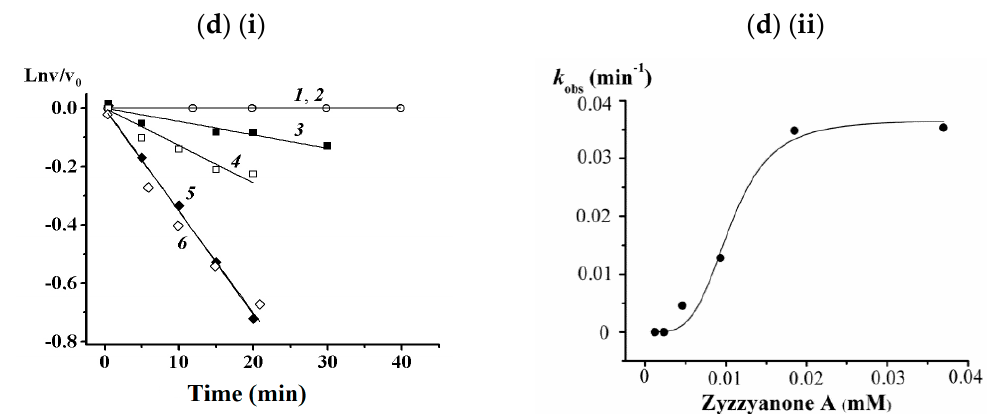
Figure 2. The results of kinetic studies of the α -PsGal inactivation by tested alkaloids: ( i ) the kinetic change of the residual activity of the enzyme ( v/v 0 ) in semilogarithmic coordinates at the presence of different concentrations of alkaloids; ( ii ) the inactivation rate ( k obs ) dependence on the concentration of alkaloids; ( a ) isoaaptamine: 814 µ M ( 1 ), 1.63 µ M ( 2 ), 3.255 µ M ( 3 ), 6.51 µ M ( 4 ), 10.417 µ M ( 5 ); ( b ) 9-demethylaptamine: 0.104 mM ( 1 ), 0.208 mM ( 2 ), 0.417 mM ( 3 ), 0.833 mM ( 4 ), 1.67 mM ( 5 ); ( c ) makaluvamin G: 0.093 mM ( 1 ), 0.185 mM ( 2 ), 0.37 mM ( 3 ), 0.74 mM ( 4 ), 1.48 mM ( 5 ); ( d ) zyzzyanone A: 0.0116 mM ( 1 ), 0.023 mM ( 2 ), 0.046 mM ( 3 ), 0.093 mM ( 4 ), 0.185 mM ( 5 ), 0.37 mM ( 6 ). All of the experiments were performed in duplicates.